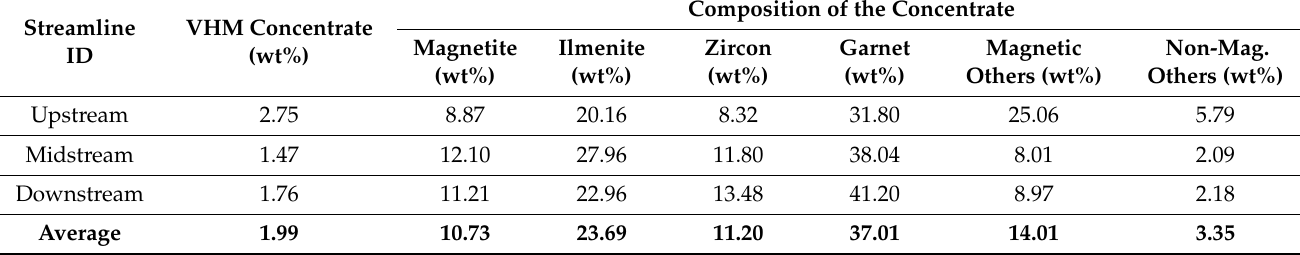
Table 3. Results of IRMS and ESPS separations conducted on the combined VHM concentrates from the Wilfley shaking table. Streamline